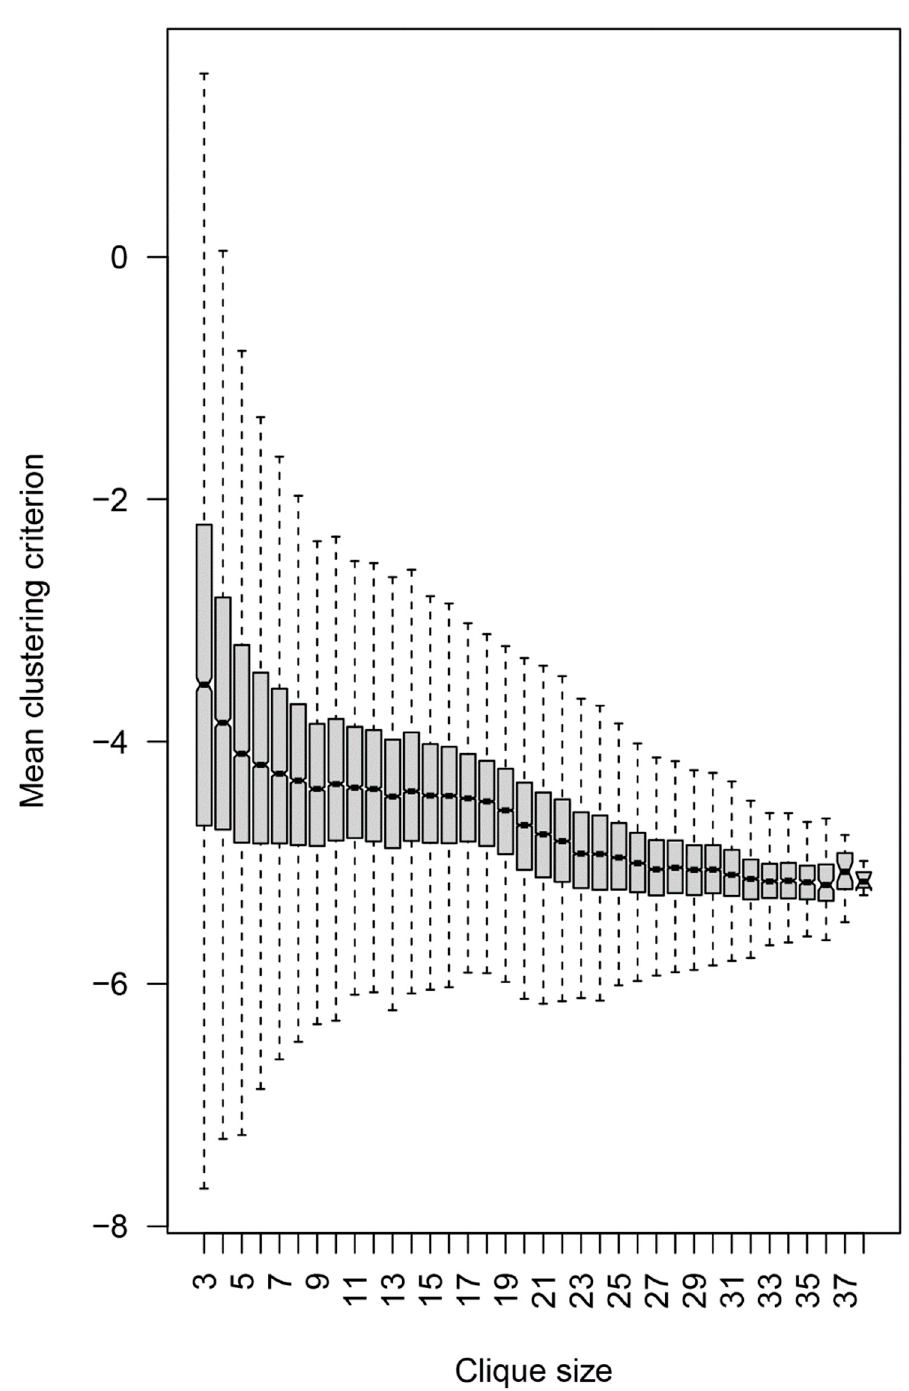
Figure 10. Dependence of the mean clustering criterion on the clique size. The composite clustering criterion based on the sum of the Dunn’s and the Baker–Hubert gamma criteria, and connectivity was used to measure the separation of the point clouds corresponding to the three diagnostic groups. Up to 100 samples of three vertices (peptides) from each clique with more than three vertices were used. The reactivity values of the 21 patients in each of these samples were used to calculate the criterion, and the values for each clique were averaged. Thus, all values were based on three-dimensional spaces. Without feature selection, the separation between the diagnostic groups was poor, hence the negative values, but the extreme values of the criterion were positive for the 3- and 4-cliques.